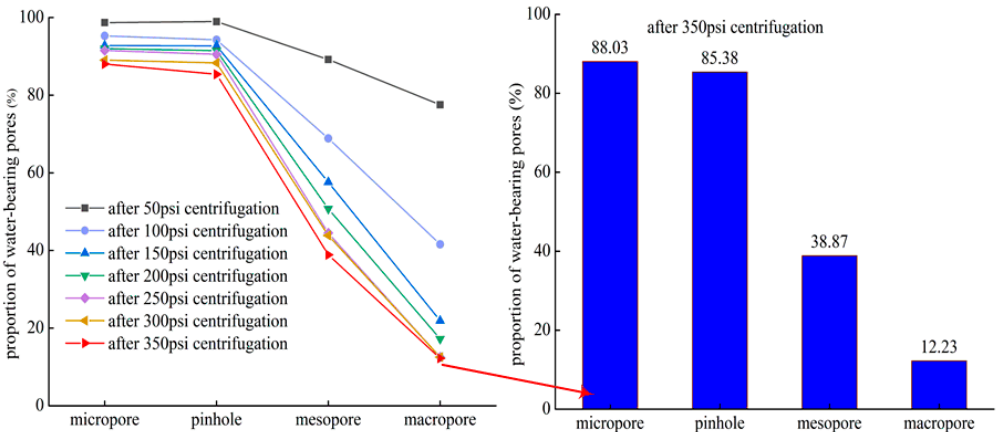
Figure 6. Proportion of water-bearing pores in different pores of tight sandstone cores after the application of centrifugal force.